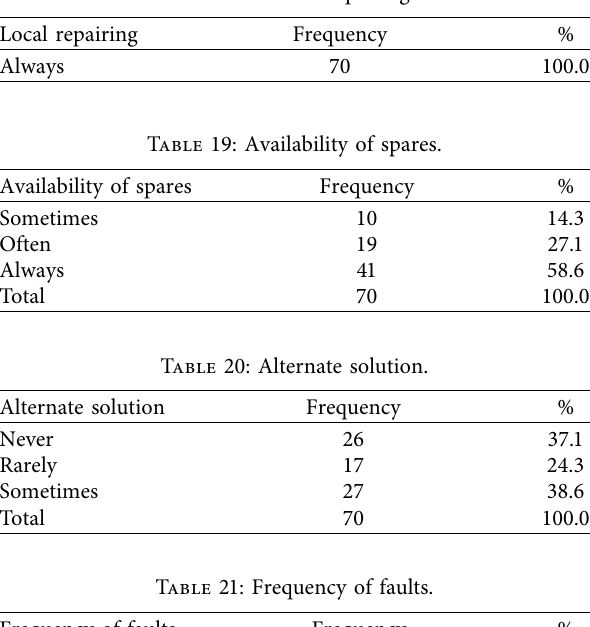
Table 12: Concentration/stress level.